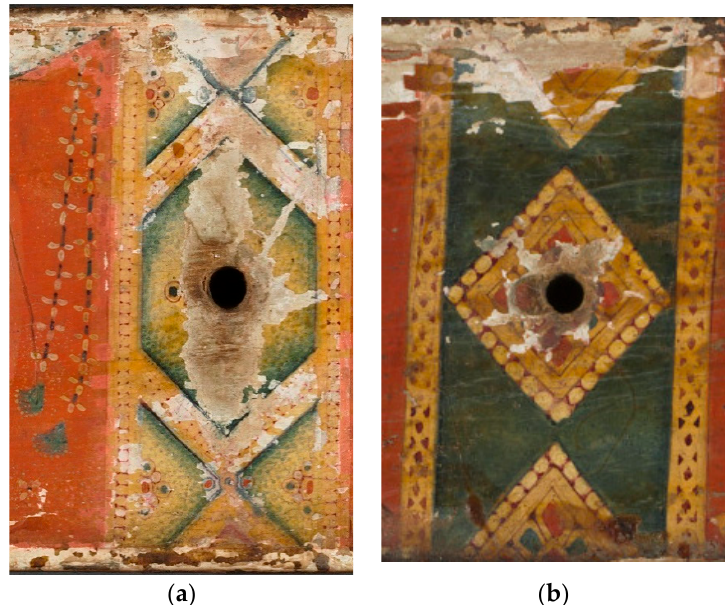
( a ) ( b ) Figure 15. Examples on the top cover ( a ) and bottom cover ( b ) of the binding ribbons painted on wood was burning in them, as a token of worship for the perfection of wisdom. And in the middle of that the interior sides of both wooden covers. Perfection of Wisdom in Eight Thousand Lines: